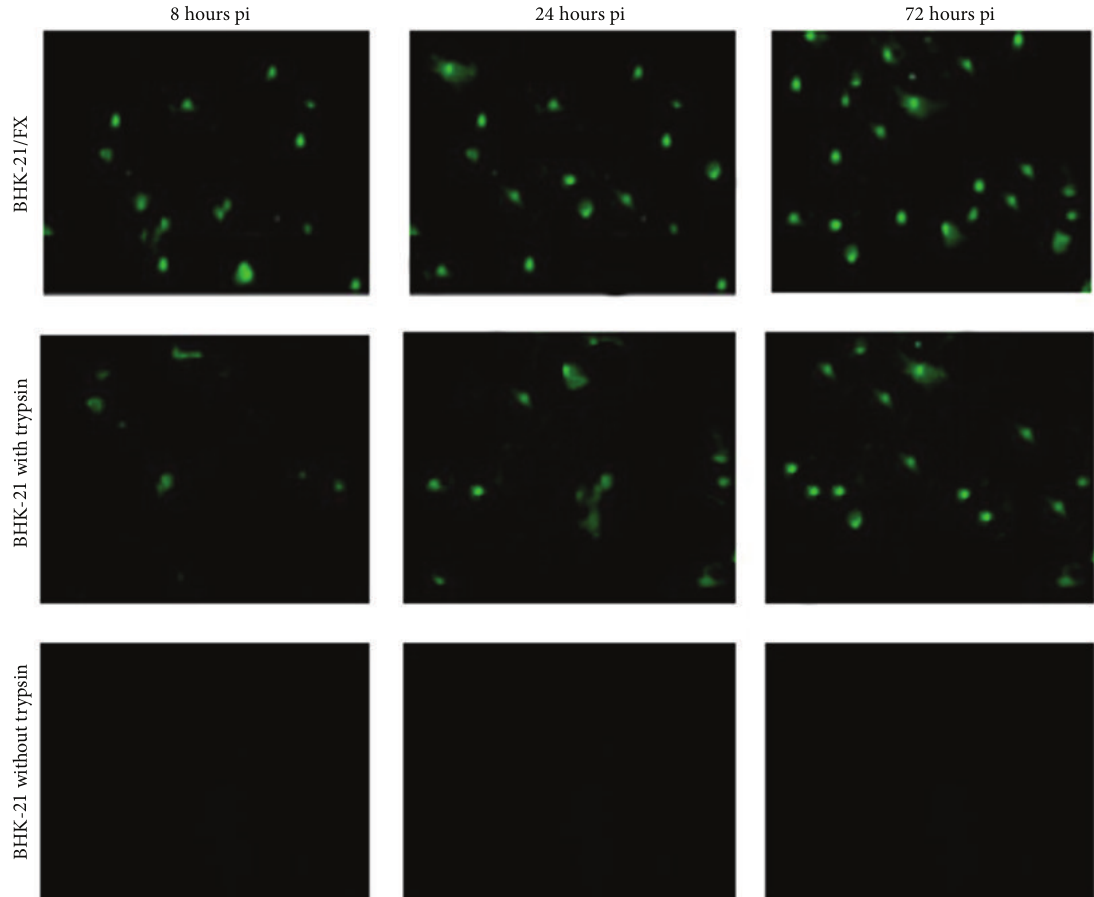
Figure 3: Immunofluorescent detection of influenza virus NP in infected-BHK-21/FX cells ( × 100). Fluorescence emission was detected in the infected cells at 24 and 72 hours post infection compared to the virus infected-BHK-21 cells supplemented with trypsin and without trypsin.